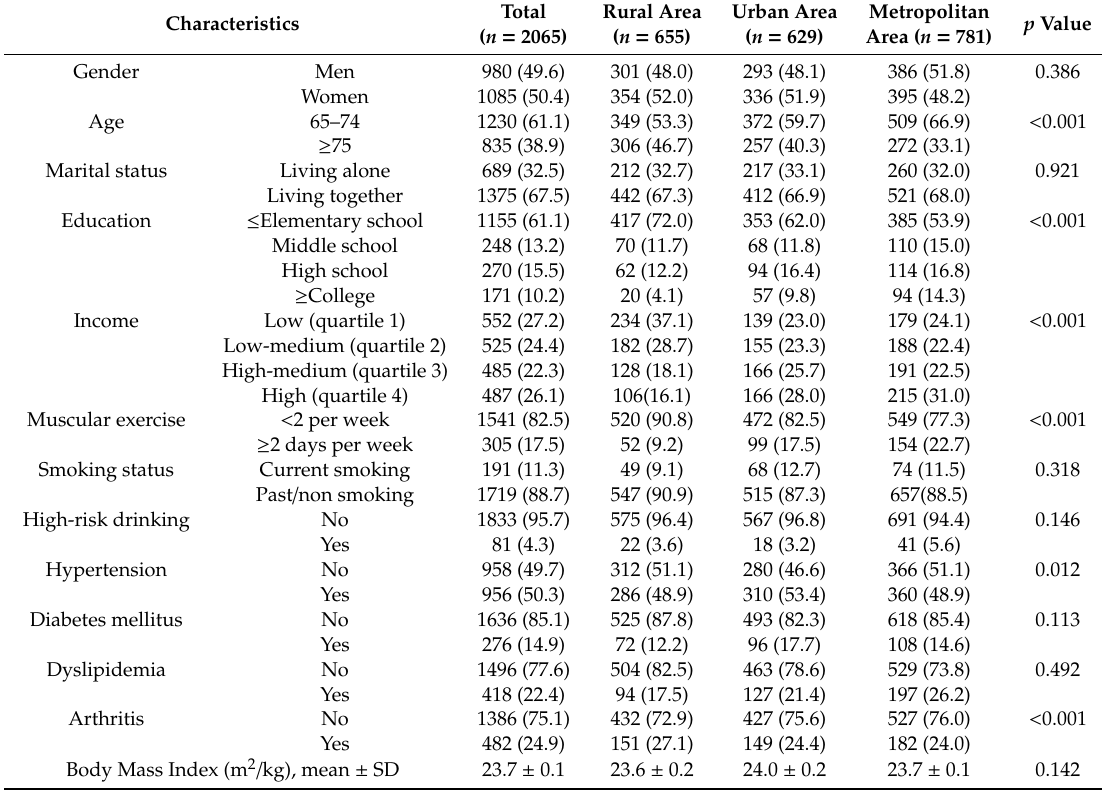
Table 1. Sociodemographic and health-related characteristics by residential